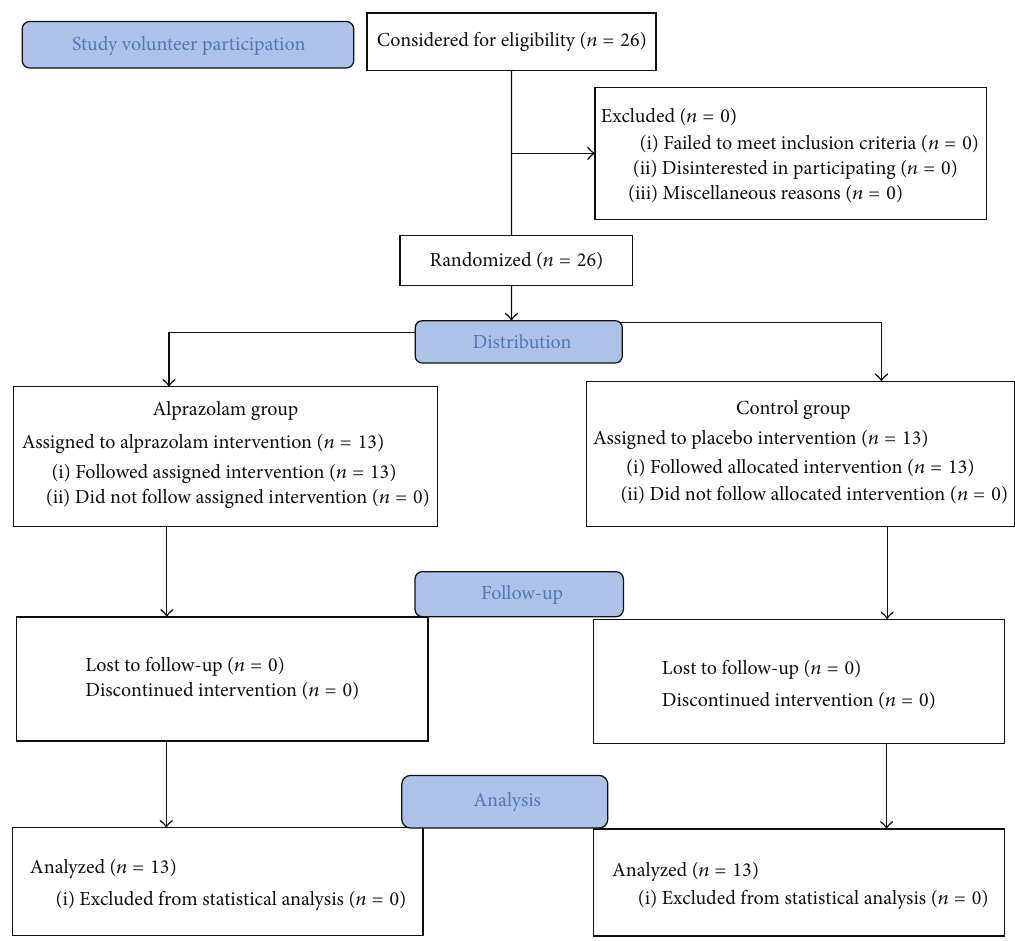
Figure 1: CONSORT 2010 Flow